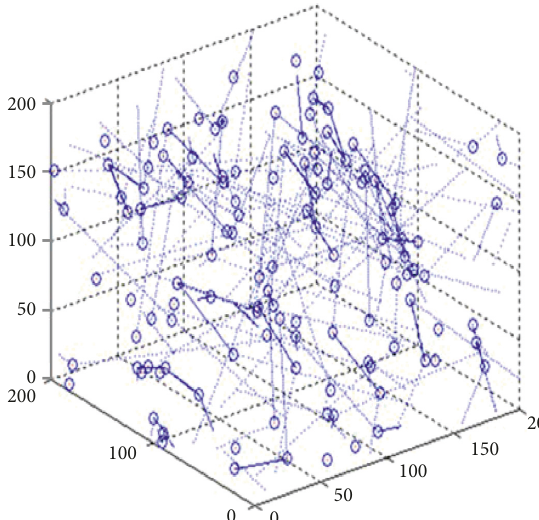
Figure 1: Three-dimensional moving trajectory of theGauss–Markov mobility